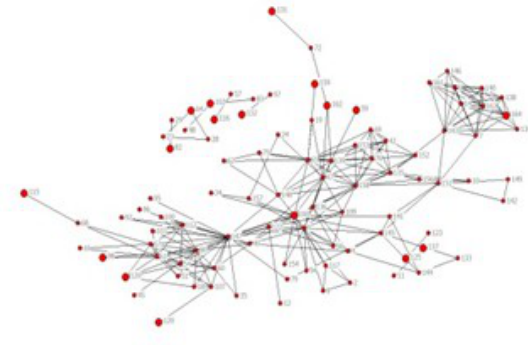
Figure 6. The SSE 180-Index Sample Stock Network Topology with Threshold 0.7